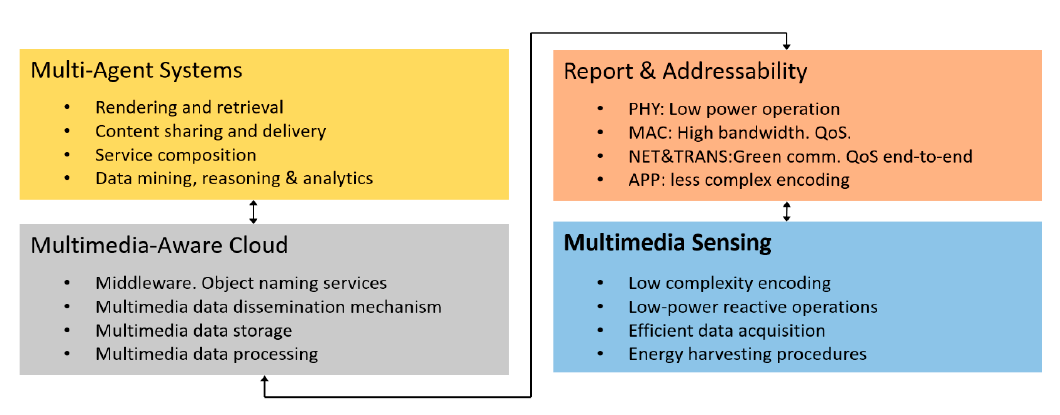
Figure 1. Levels on an Internet of Multimedia Things (IoMT) arquitecture [5].